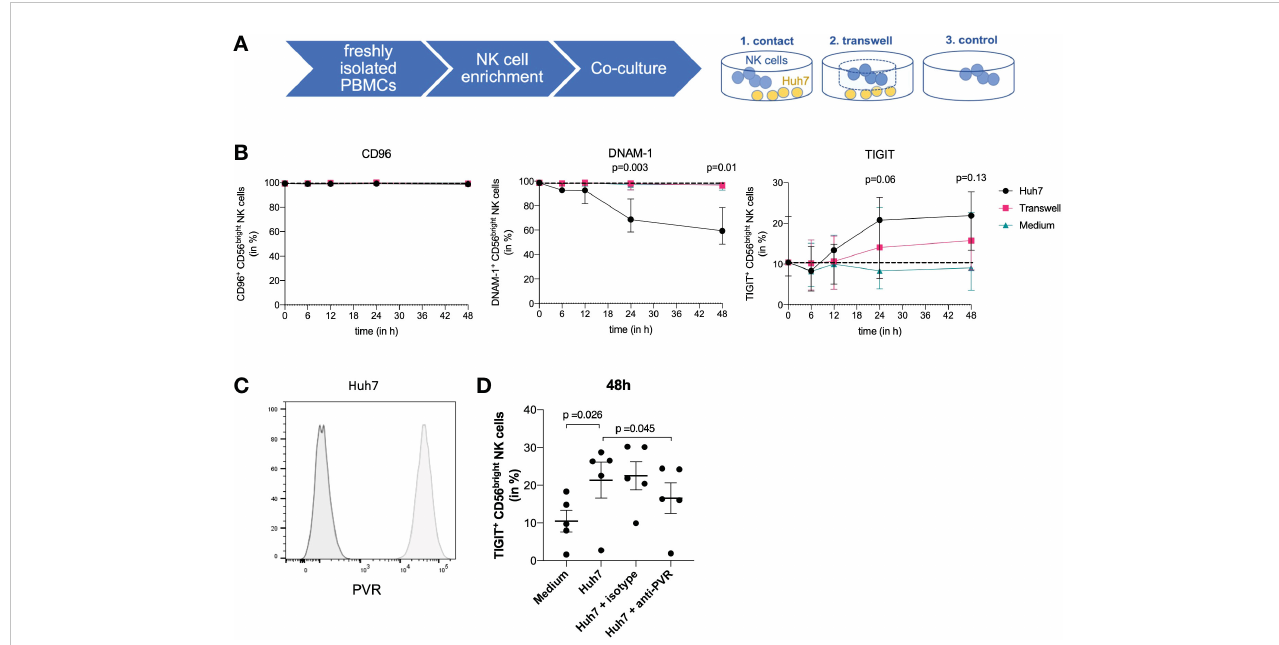
FIGURE 4 Co-culture of NK cells and Huh7 cells. (A) Co-culture experiments using isolated NK cells from peripheral blood from healthy control individuals and Huh7 cells. NK cells were either cultured in direct contact with Huh7 cells, in a transwell insert with the size of 1 µm to ensure indirect contact with Huh7 cells or with medium only. (B) Graphs are displaying quantitative analysis of CD96, DNAM-1 and TIGIT expression on CD56 bright NK cells after 6, 12, 24 and 48 hours. At the timepoints 6, 12, and 24 hours a total of 5 healthy control individuals was used for comparison. At 48 hours, a total of 4 out of the 5 mentioned healthy control individuals were assessed for CD96, DNAM-1 and TIGIT. Black dots representing direct contact, pink squares the transwell insert and blue triangles medium only. Paired t-test was used to determine the displayed statistical differences between direct contact of NK cells and medium control. Each dot represents the median of the individuals; error bars represent the data range. (C) Representative histograms comparing PVR staining (light grey) and unstained control (dark grey) demonstrating PVR expression on Huh7 cells. (D) Graph displays the percentage of TIGIT + NK cells in different conditions: NK cells only, NK cells in direct contact with Huh7 cells, isotype control and NK cells in direct contact with Huh7 cells including blocking of PVR with an anti-PVR-antibody. Data are shown for 5 paired experiments using NK cells derived from 3 different donors. Statistical analysis for signi fi cance was performed using a two-tailed paired T